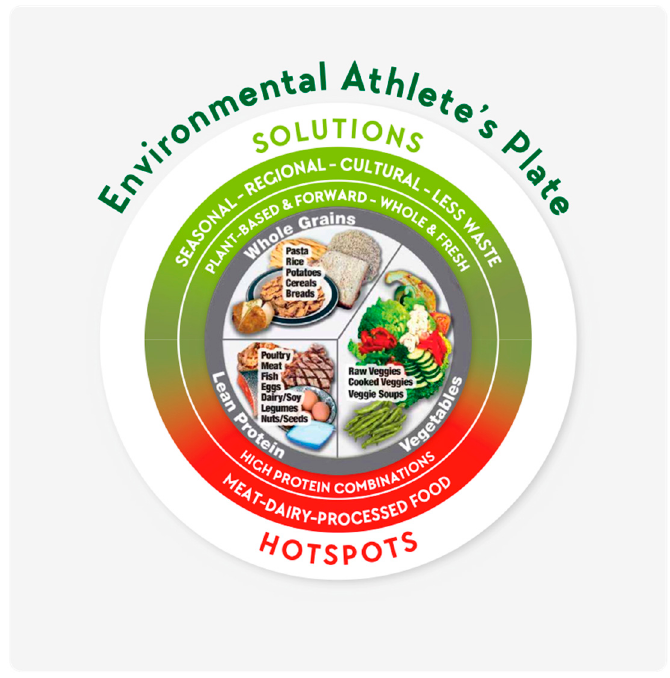
Figure 8. The Environmental Athlete’s Plate.